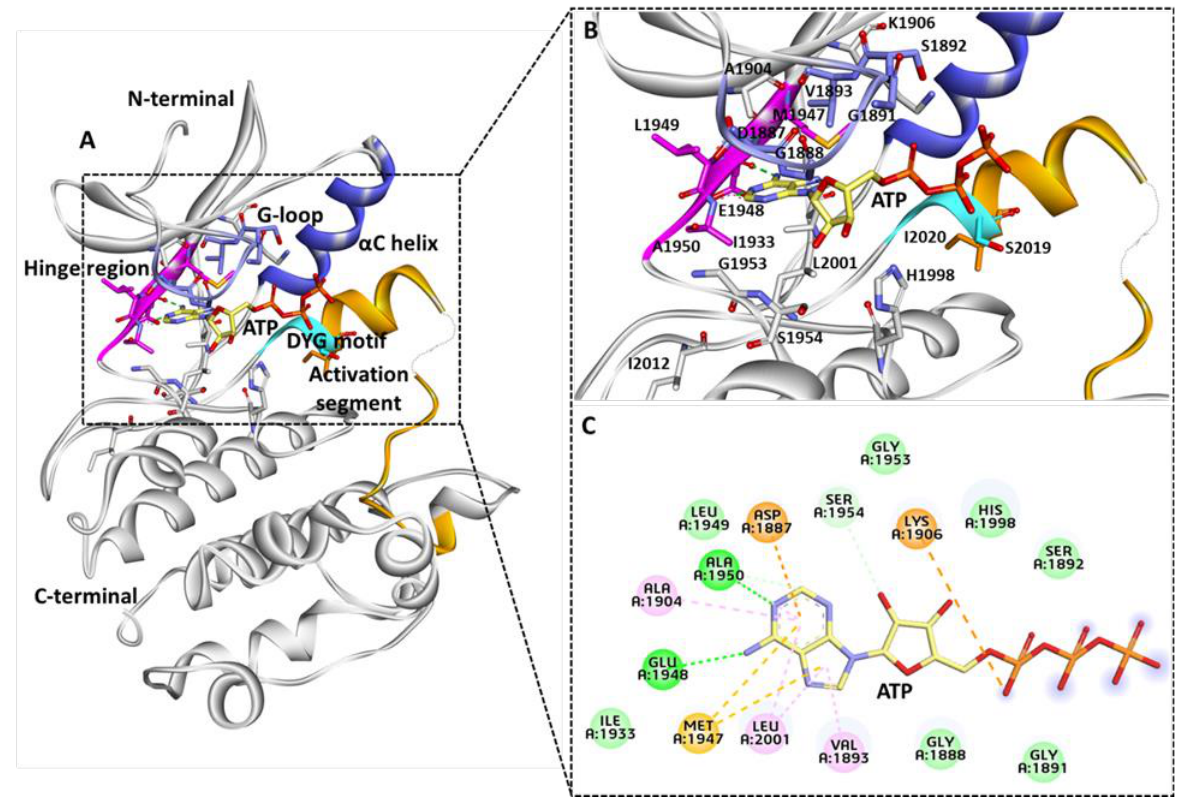
Figure 2. ( A ) Kinase domain ATP binding site. ( B , C ) Key molecular interactions involved in ATP interaction 3D and 2D representation. Important regions of active site G-loop (purple), hinge region (pink), DYG motif (cyan), and activation segment (orange), αC helix (blue) , and the remaining part of the LRRK2 kinase domain is shown in grey-colored ribbon. ATP molecule is shown with a yellow stick. Figure created using Discovery Studio (DS) v19 (access date 12 February 2022) [69] .